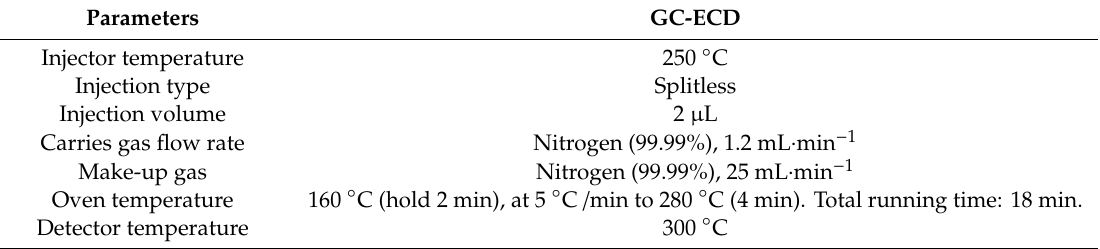
Table 1. The parameters of GC-ECD for lindane